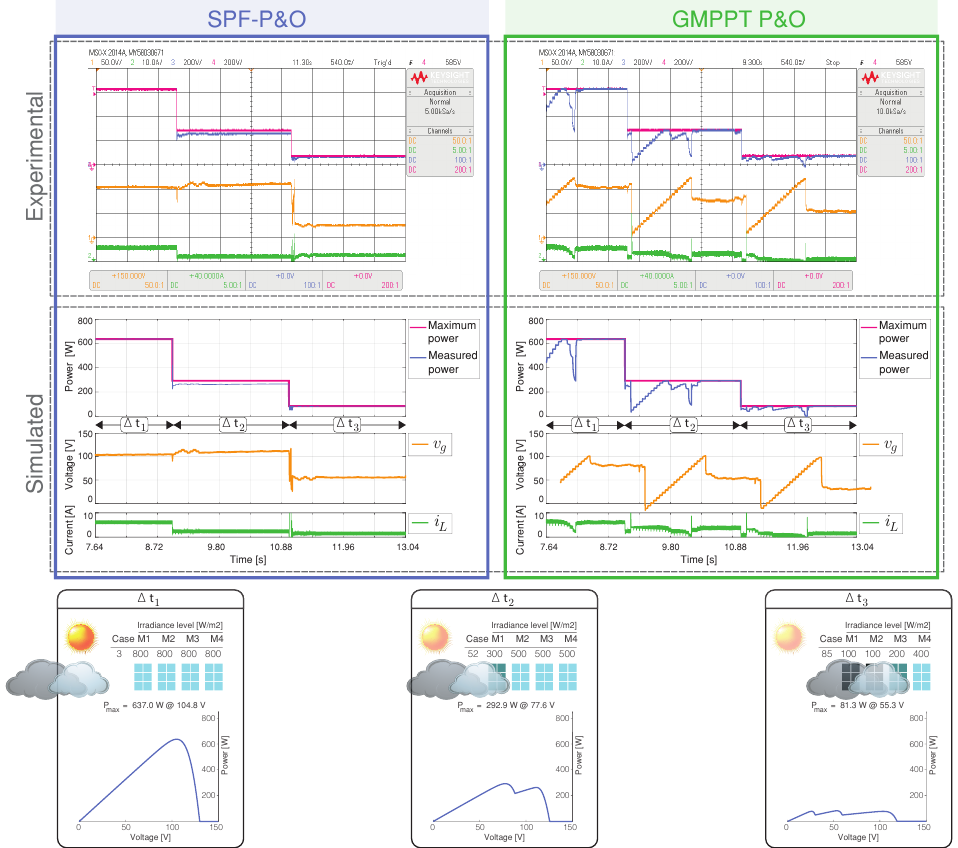
Figure 11. Simulated and experimental dynamic behavior of the MPPT algorithms for Scenario 4 with an output voltage V o = 160 V. The proposed MPPT algorithm (right) is compared with the GMPPT P&O algorithm (right). CH1: v g (50 V/div), CH2: i L (10 A/div), CH3: Maximum power (200 W/div), CH4: Measured power (200 W/div) and a time base of 540